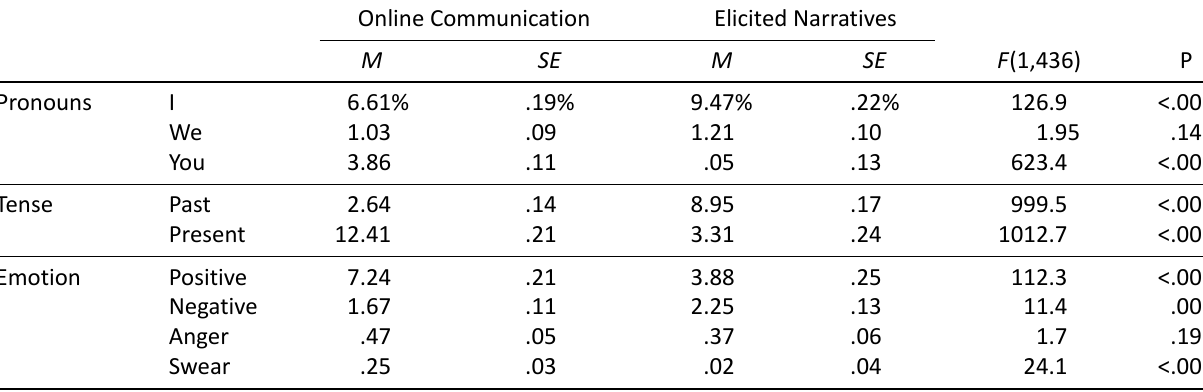
Table 1. Mean ( SD ) discourse features across online communication and elicited narratives as a percentage of total words.